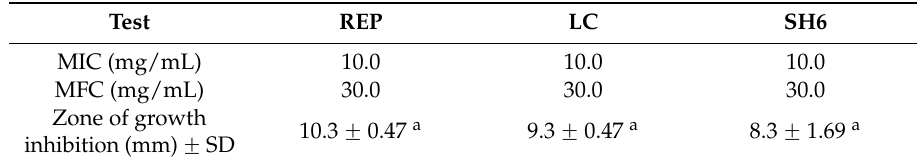
Table 3. Minimal inhibitory concentration (MIC), minimal fungicidal concentration (MFC), and antagonistic activity of lambertianin C (LC), sanguiin H-6 (SH6), and the raspberry ellagitannin preparation (REP) with respect to Geotrichum candidum LOCK